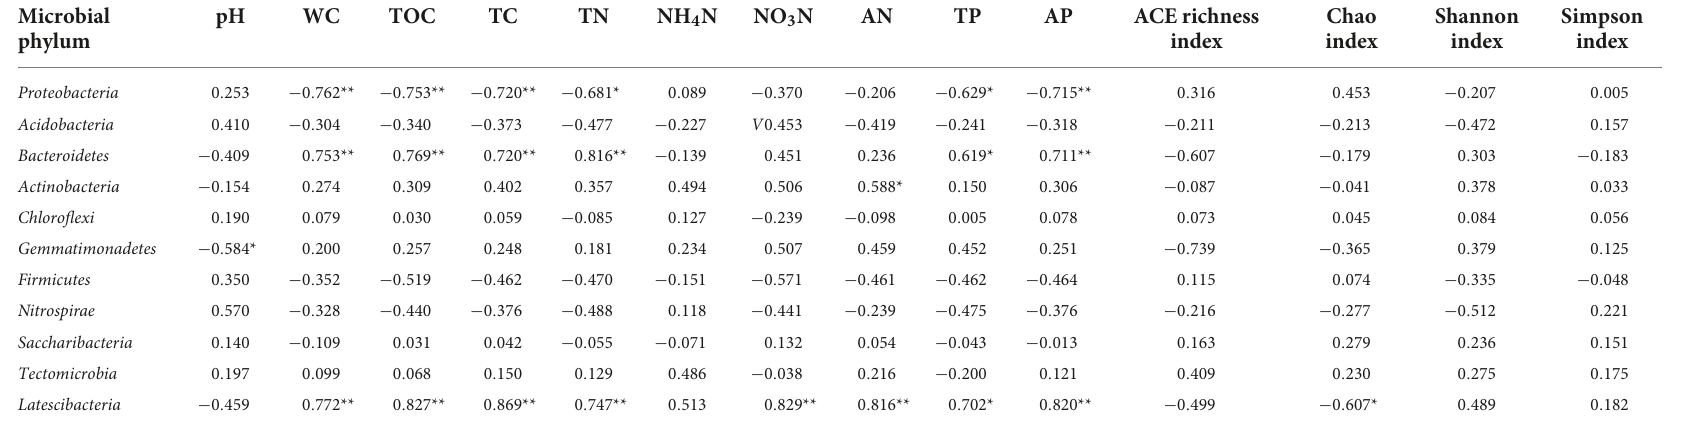
TABLE 3 Correlation between the soil microbial abundance (phylum level), soil physico-chemical properties and Alpha diversity indices. Microbial phylum